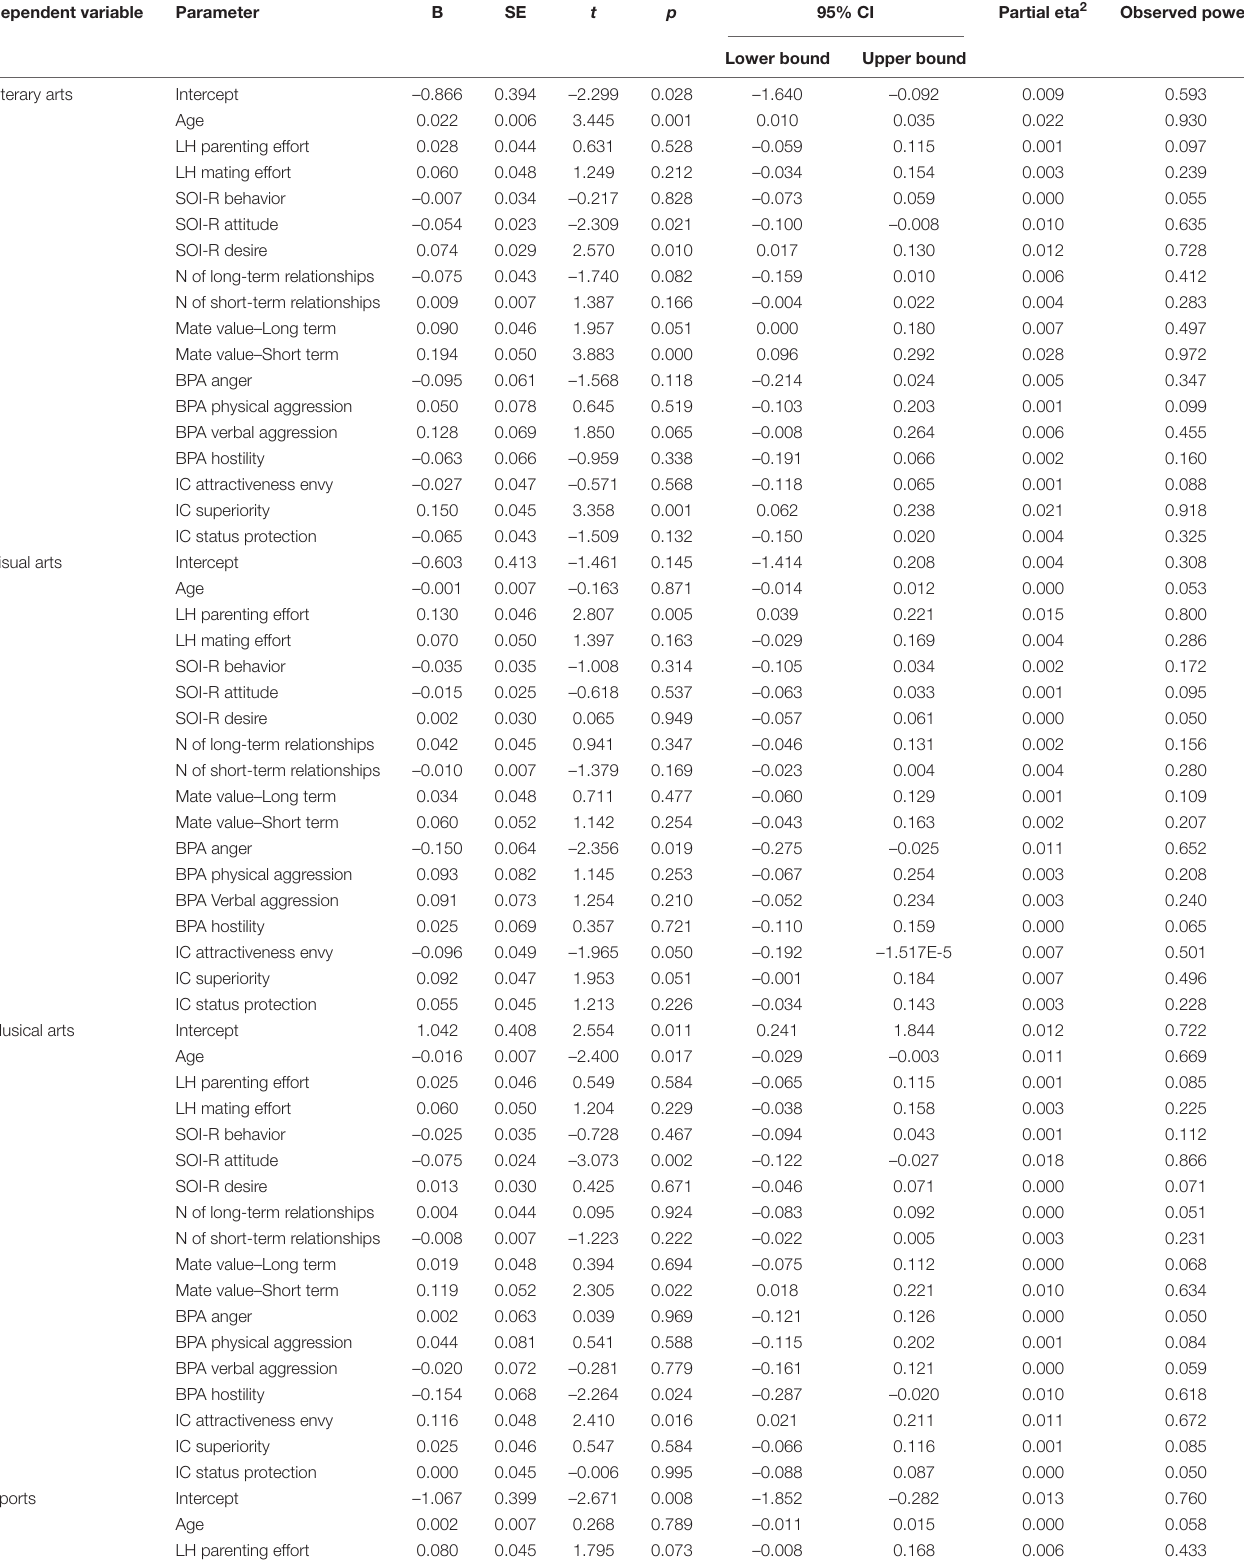
TABLE 2 | Parameter estimates of the multivariate general linear model (GLM) model indicating the effect of the independent variables on artisticality in women. Dependent